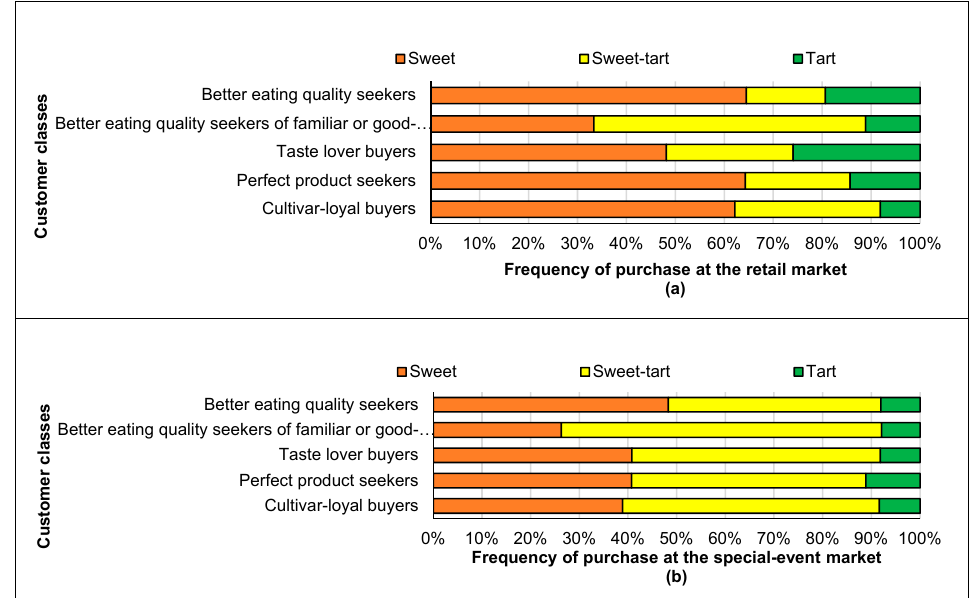
Figure 4. Taste category (sweet, sweet-tart, tart) of apples preferred by different classes of consumers at the retail market ( a ) and special-event market ( b ).